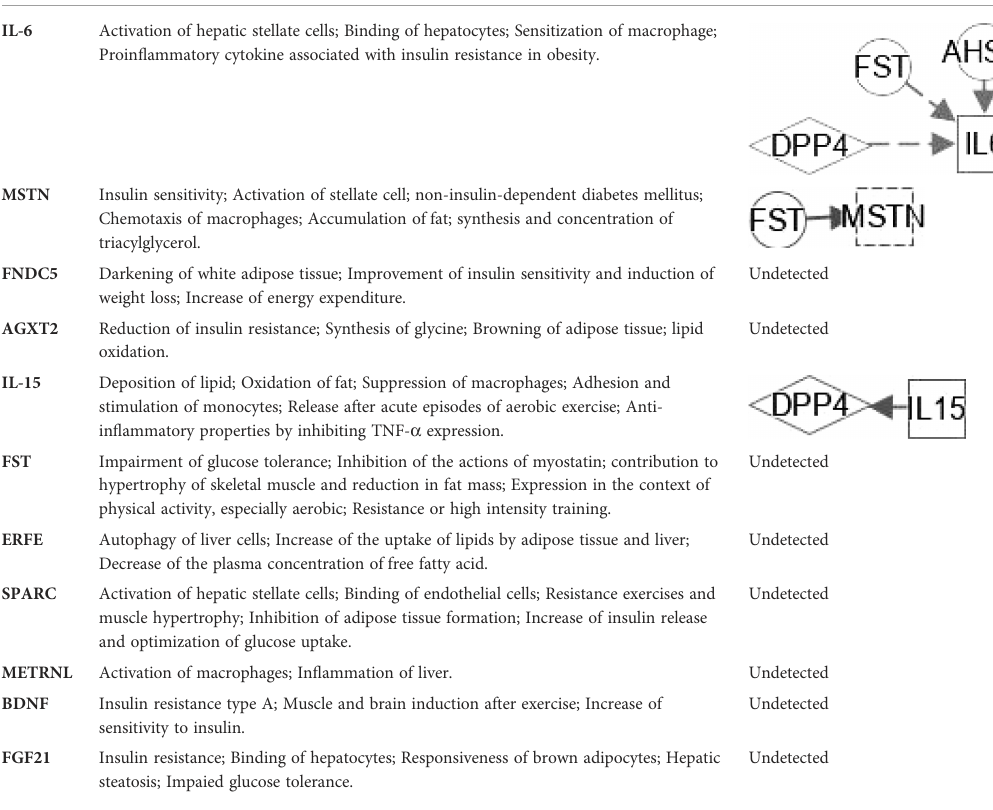
TABLE 4 IPA analysis of Cell-cell signaling and interaction of muscle-derived myokine. Myokine Cell-cell signaling and